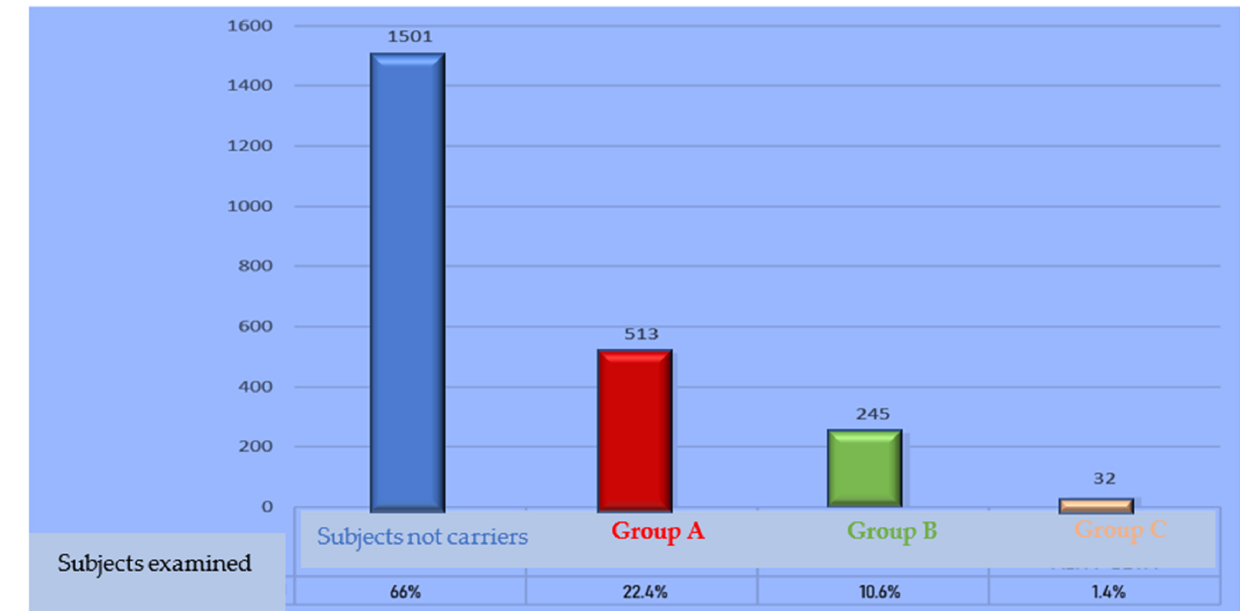
Figure 1. Schematic representation of study’s sample.